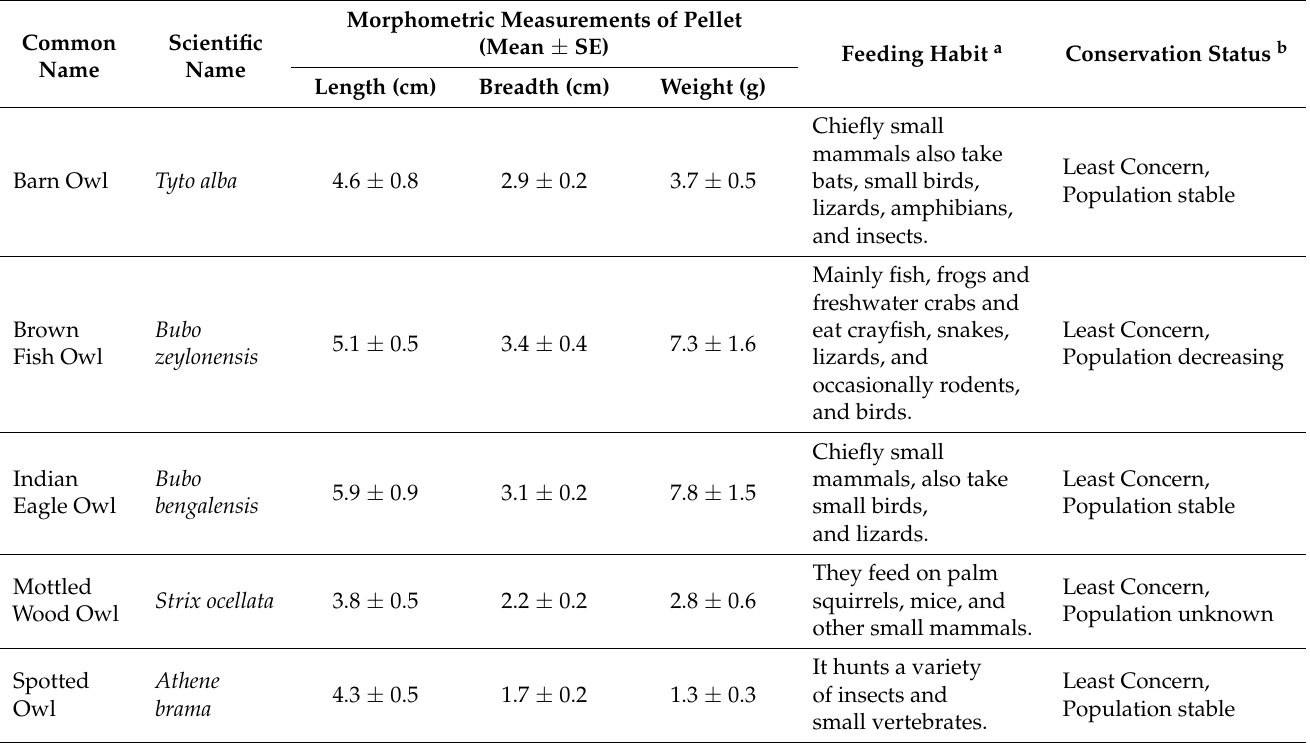
Table 1. Various owl pellets collected from the farms of the Cauvery Deltaic